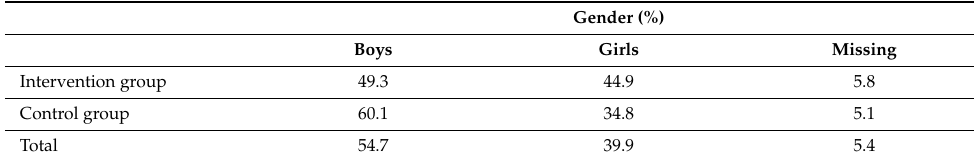
Table 1. Gender distribution of the sample. Gender (%) Boys Girls